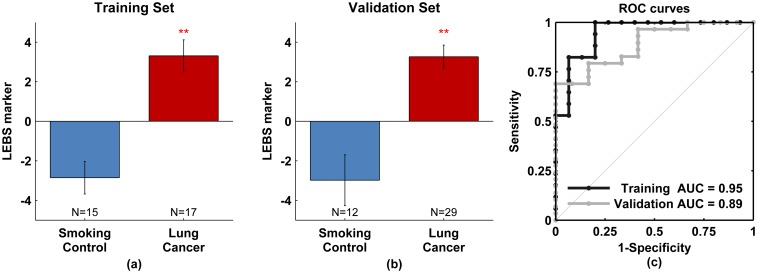
LEBS marker diagnostic power.Composite LEBS marker calculated using linear combination of LEBS parameters of  and  shows highly significant alteration (p<0.001) between smoking controls and lung cancer patients in both training and validation sets (panels a and b). c) Receiver operating characteristic (ROC) curve for training and validations sets. The area under the curve (AUC) is 0.95 for the training set and 0.89 for the validation set. The double red star indicates statistical significance at the 0.1% level.